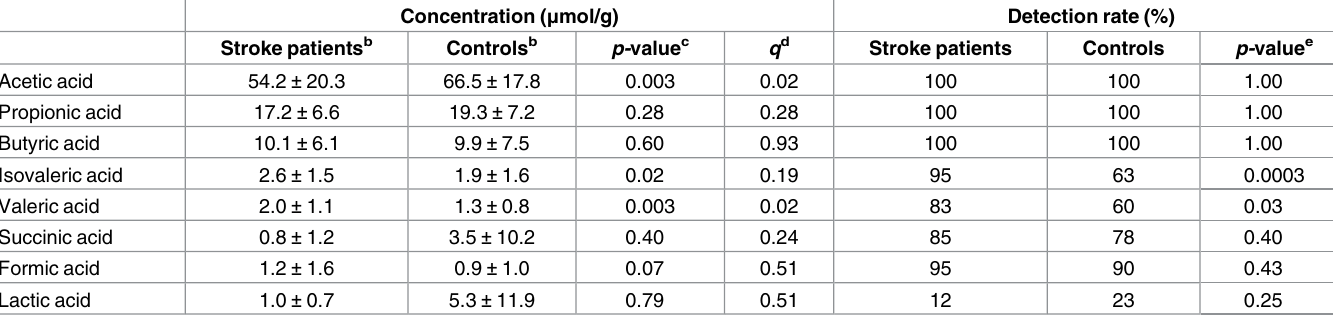
Table 5. Comparison of the concentrations of fecal organic acids between patients with stroke and control subjects.